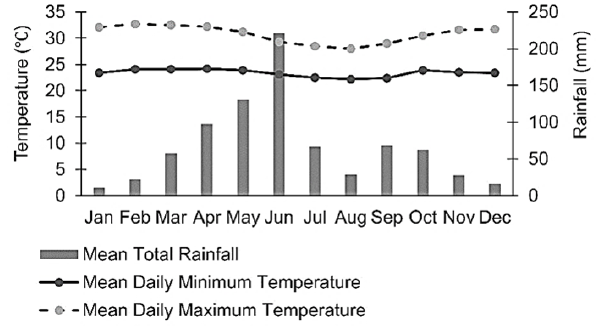
Figure 2. Climate (30-year average) of the study area. (Data source: Ghana Meteorological Agency,